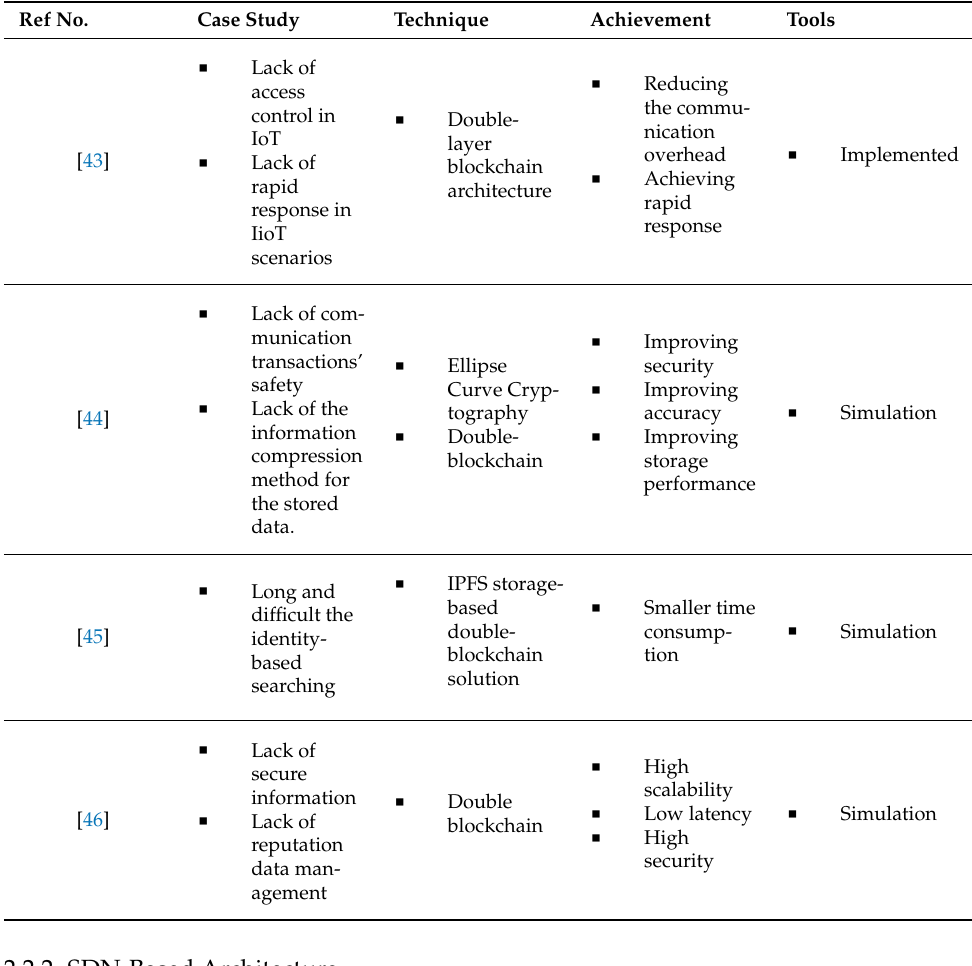
Table 3. Selected Articles.